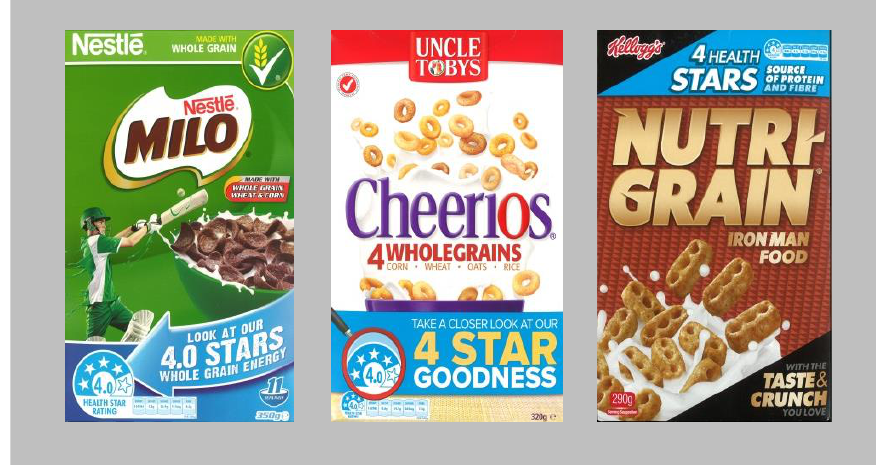
Figure 4. HSR label based ‘superFoP’ cold cereal prime facing designs (New Zealand 2014–2016).